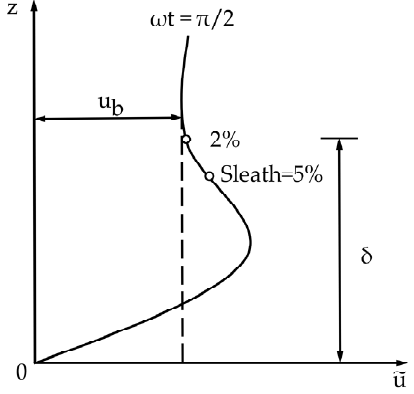
Figure 5. Wave boundary layer thickness δ .